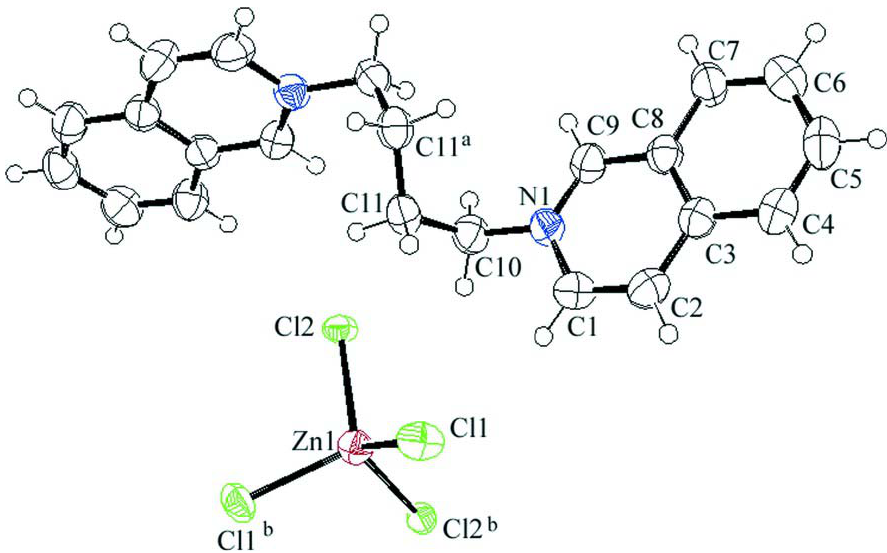
Figure 1 The molecular structure showing the atom-labeling scheme. Displacement ellipsoids are drawn at the 50% probability level [symmetry codes: (a) - x , y , 3/2- z ; (b) - x , y , 1/2- z ]. 2,2 ′ -(Butane-1,4-diyl)diisoquinolinium